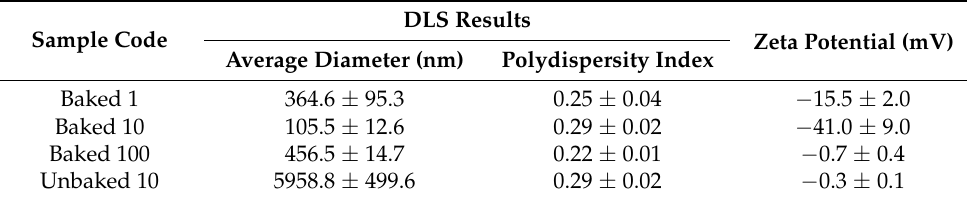
Table 1. Summary of dynamic light scattering (DLS) and zeta potential results of AgNPs samples.